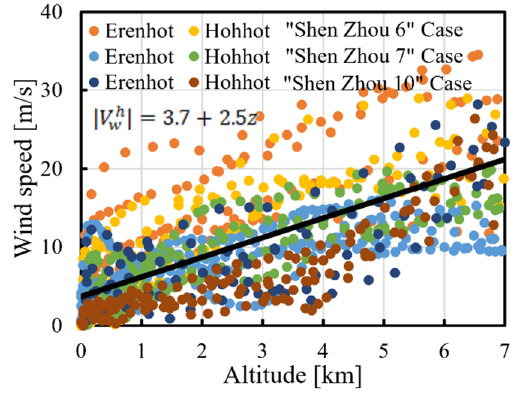
Figure 16. WRF forecasts data used to create linear approximations of how wind speed varies with height.